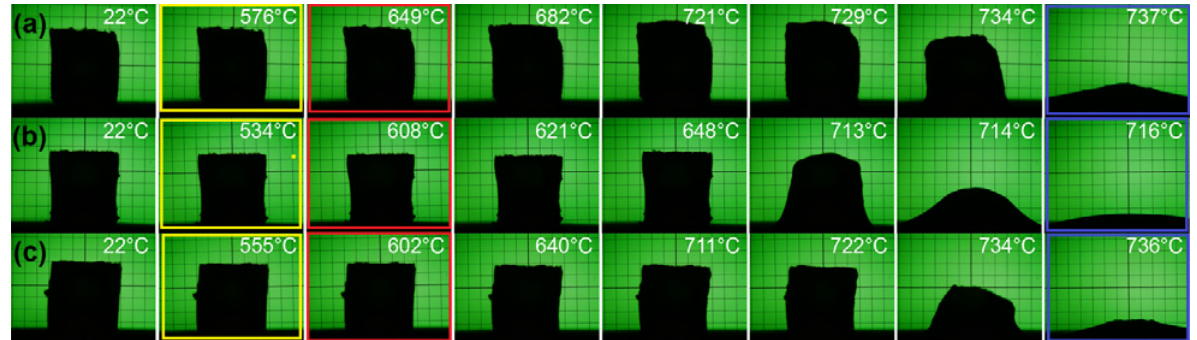
Fig. 2 Images from hot-stage microscope during heating in the temperature range of 22–740 ℃ : (a) Li 2 WO 4 , (b) Li 2 WO 4 with 4% AlF 3 –CaB 4 O 7 , and (c) Li 2 WO 4 with 4% CuBi 2 O 4 . Characteristic temperatures are marked by the colored frames: temperature of the start of shrinking (yellow), optimal sintering temperature (red), and melting temperature (blue).